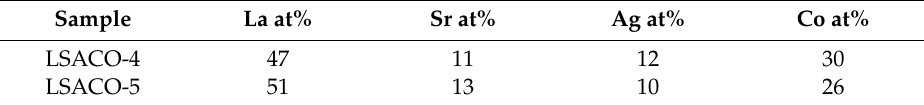
Table 4. Surface composition determined by XPS of LSACO-4 and LSACO-5 after catalytic tests. Sample La at% Sr at%